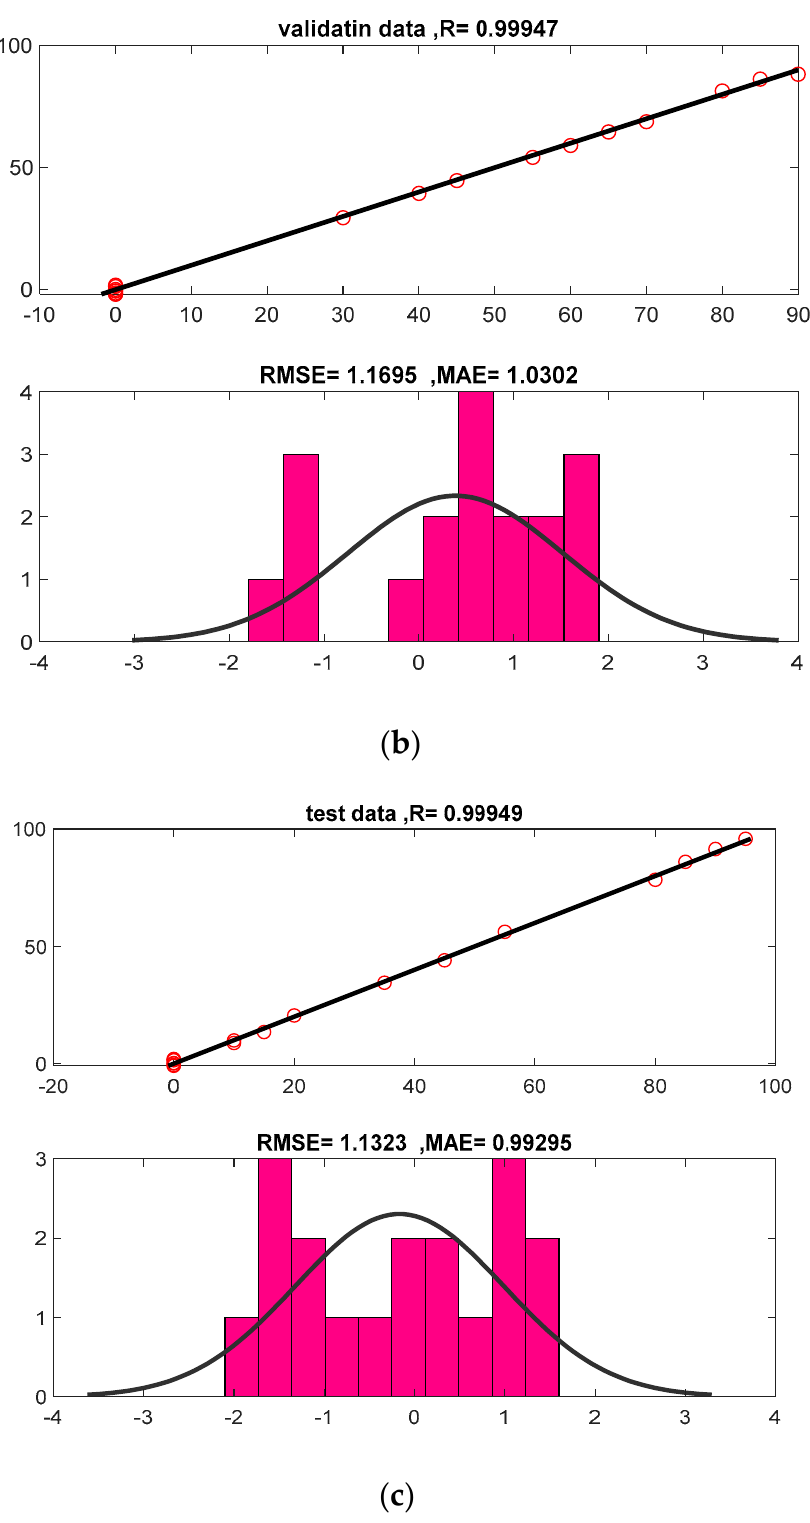
Figure 6. Operation of the designed neural network to recognize the volumetric ratio of ethylene glycol ( a ) train data, ( b ) validation data, and ( c ) test data.